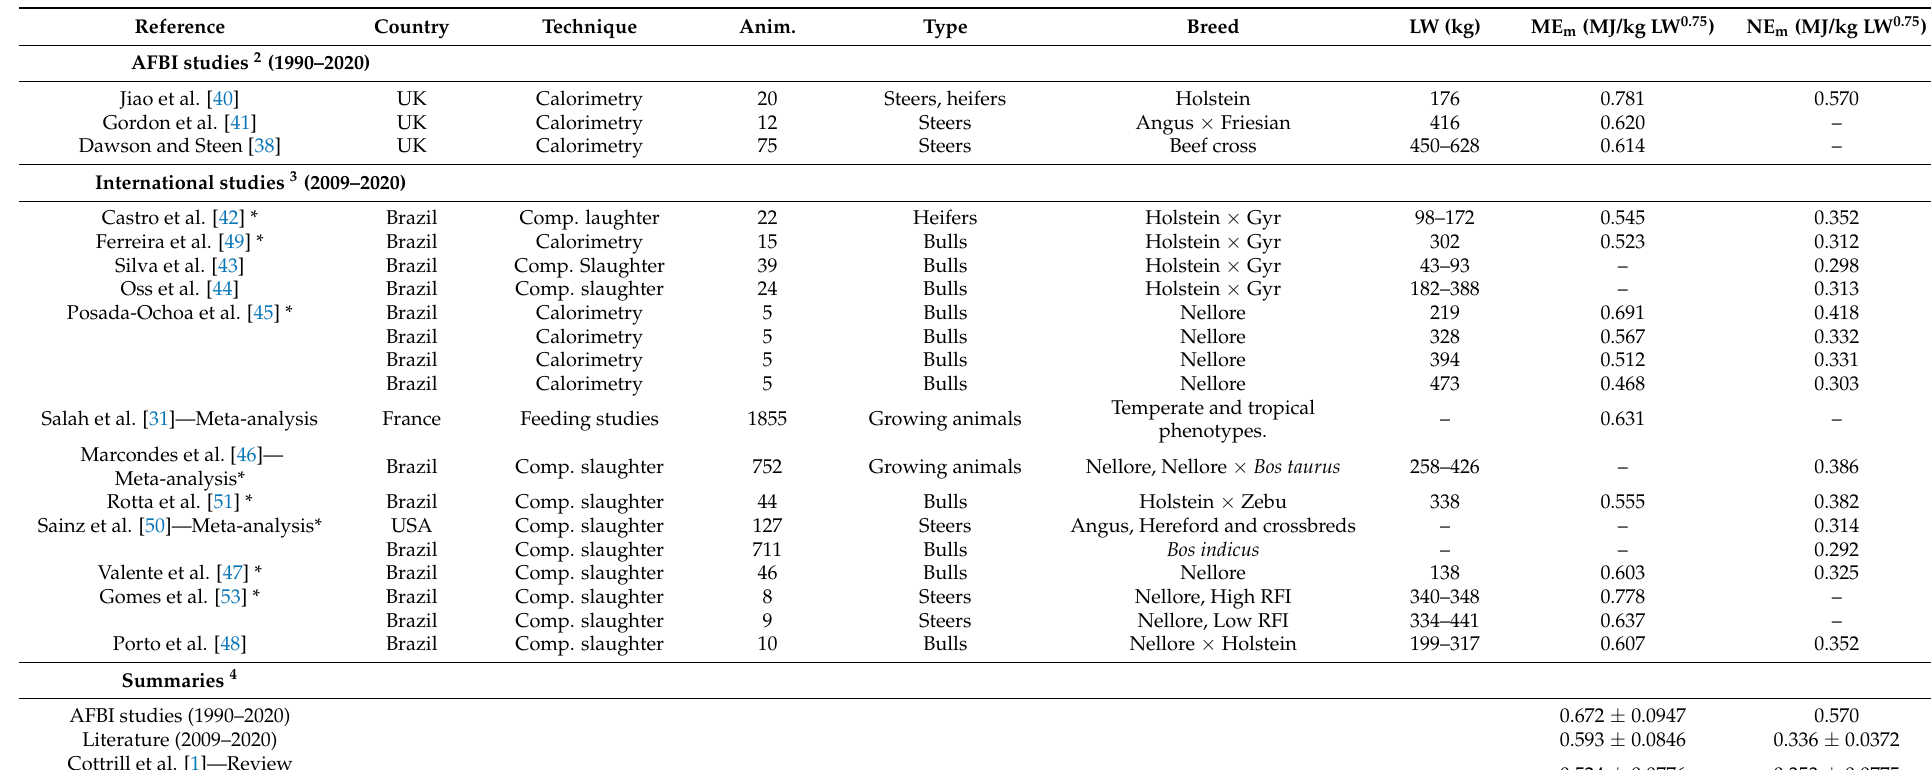
Table 2. Metabolisable and NE requirements for maintenance for growing beef cattle from recent studies published around the world 1